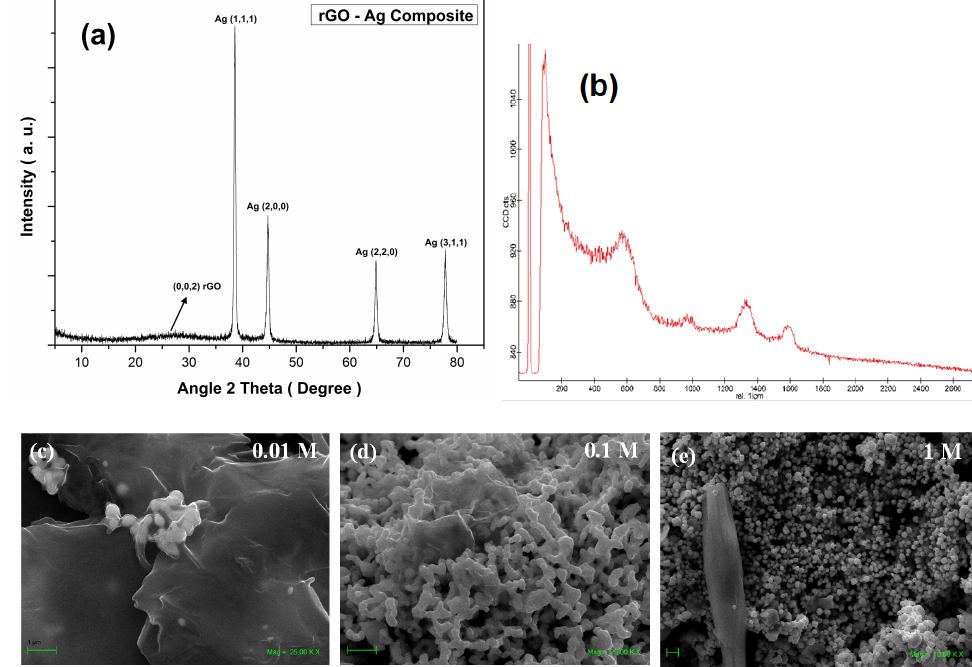
Figure 2. ( a ) XRD peaks of the synthesized rGO/Ag nanocomposites. ( b ) Raman spectra of the synthesized sample. Low and high magnification SEM images of the nanocomposites as-synthesized at ( c ) 0.01 M concentration ( d ) 0.1 M concentration, and ( e ) 1 M concentration of AgNO 3